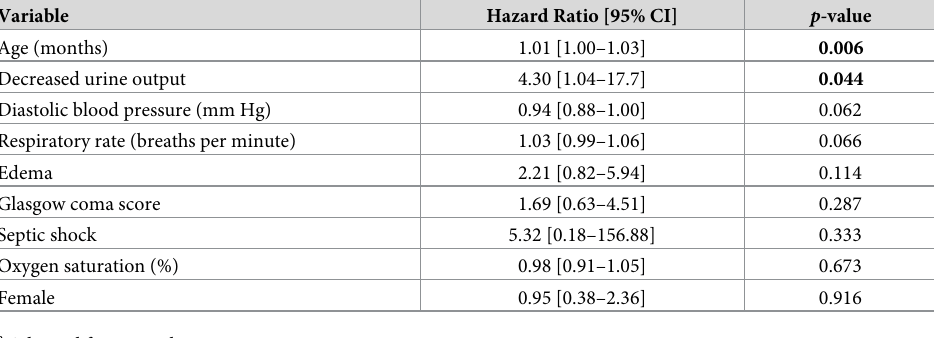
Table 4. Predictors of mortality for children with very severe anemia by multivariate analysis a